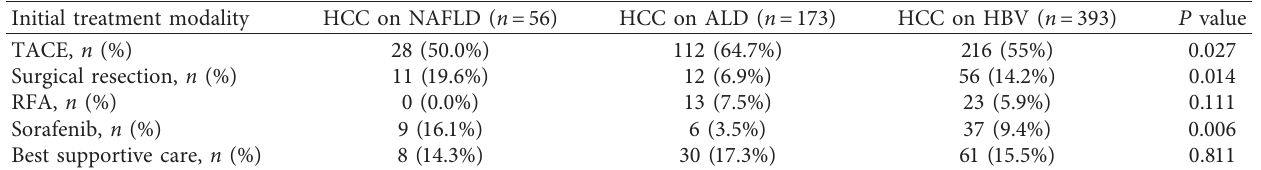
Table 3: Treatment strategies of patients.